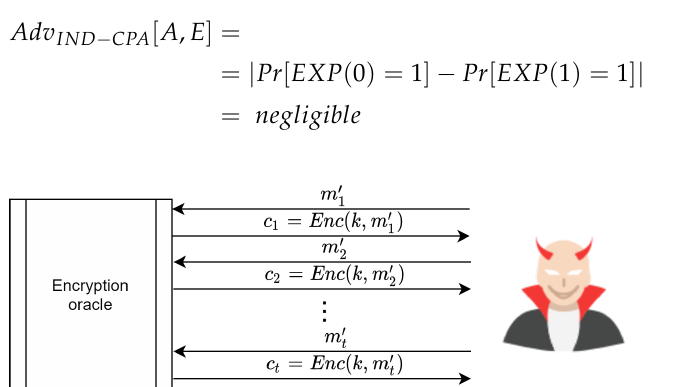
Figure 22. Adversary’s power to submit unlimited messages to encryption oracle in CPA.